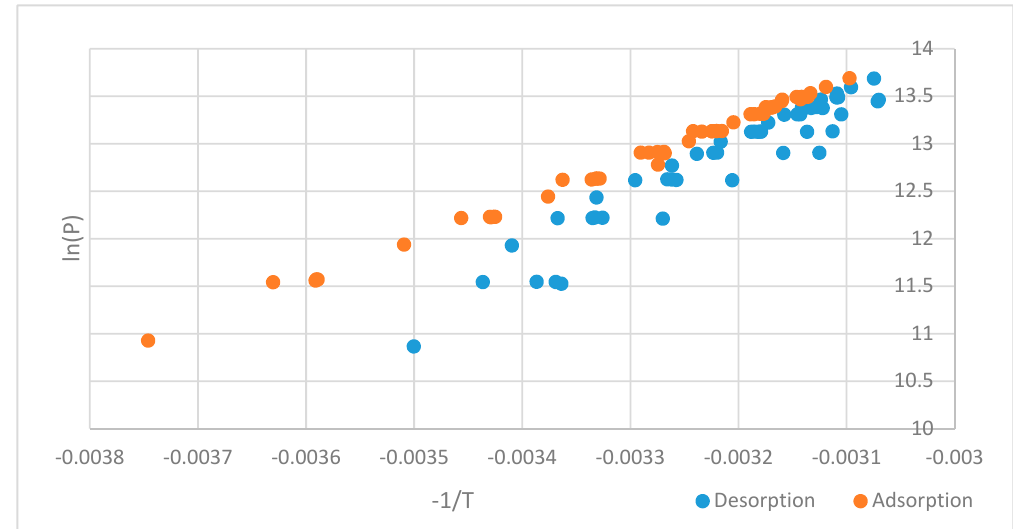
Figure 3. Equilibrium lines, shows all results for adsorption and desorption.